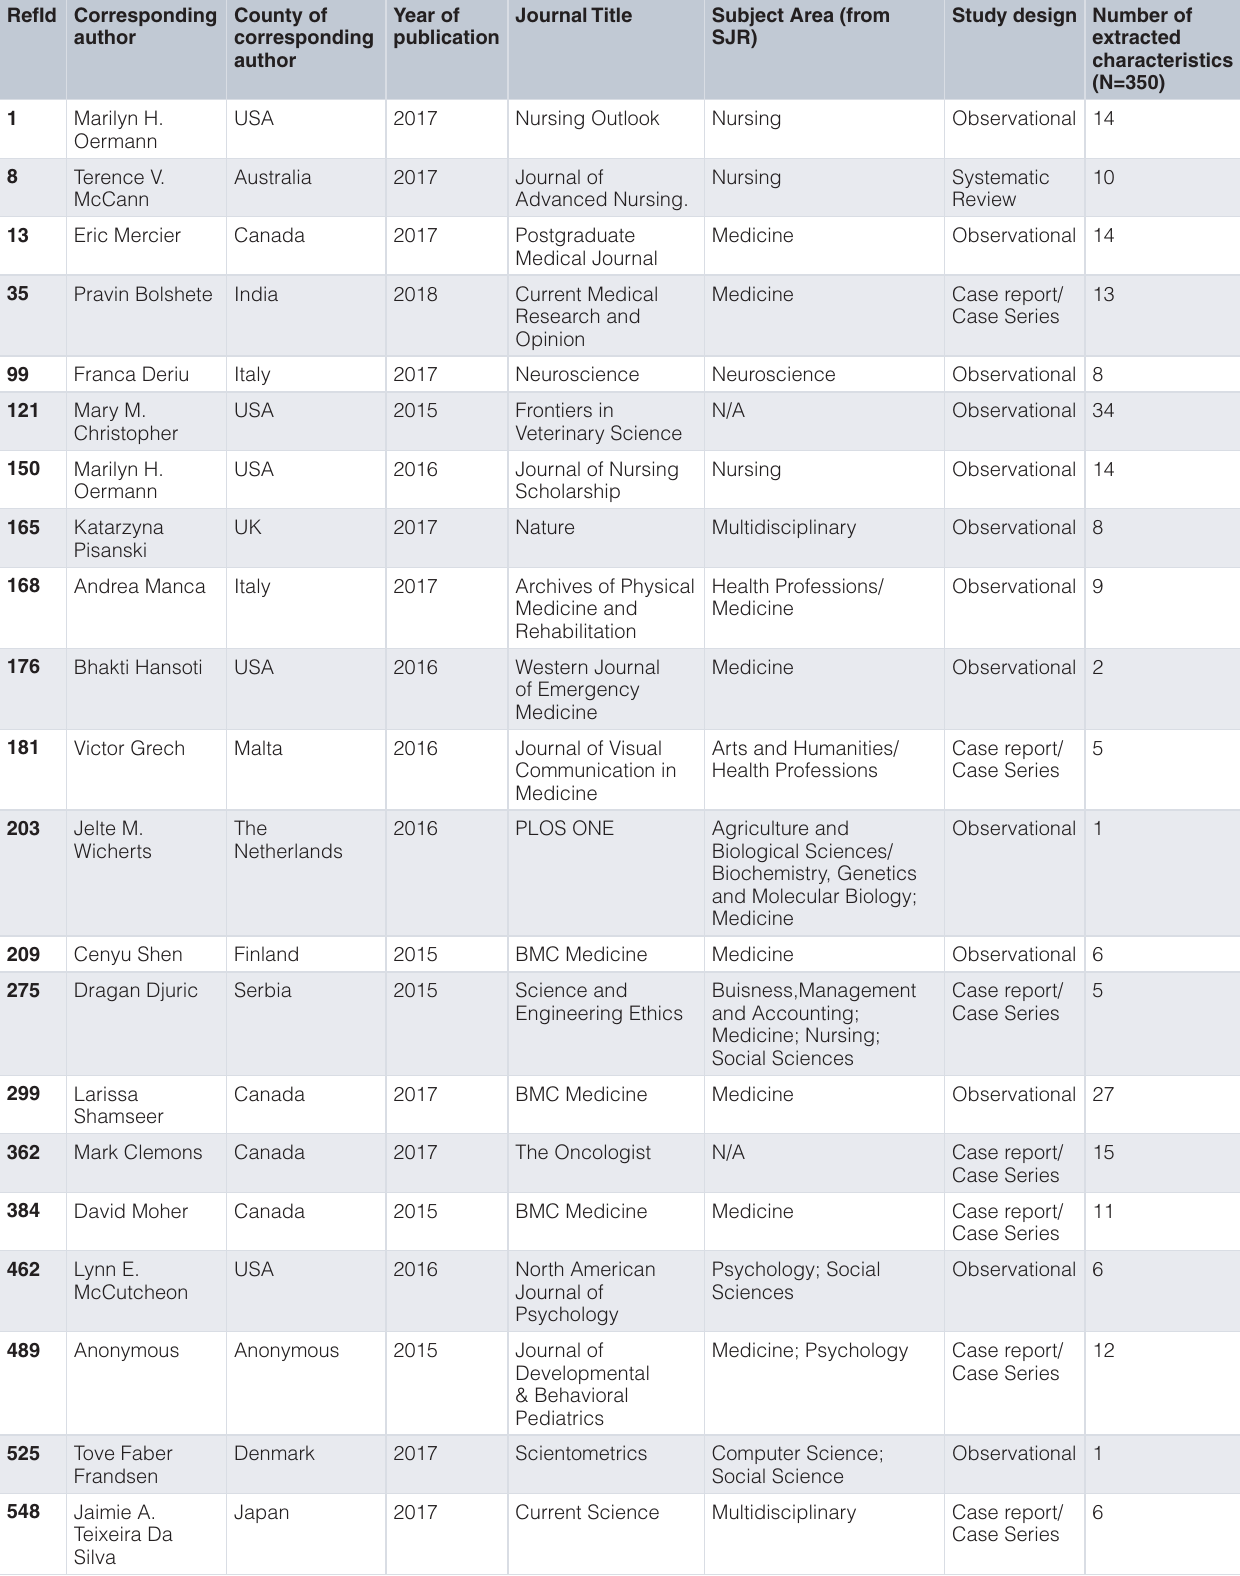
Table 2. Included empirical records (N=38). For full citations see Supplementary File